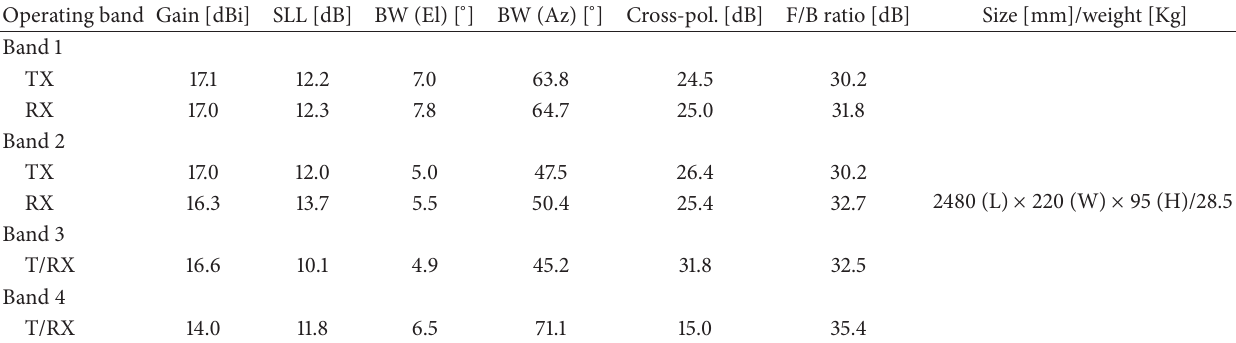
Figure 9: Measured radiation patterns of the multiband array: (a) 0.881 GHz for TX of Band 1, (b) 0.837 GHz for RX of Band 1, (c) 2.14 GHz for TX of Band 2, (d) 1.95GHz for RX of Band 2, (e) 2.30 GHz for Band 3, (f) 2.35 GHz for Band 3, (g) 5.15 GHz for Band 4, and (h) 5.50 GHz for Band 4. Table 3: Summary of minimum measured performances of the multiband base-station